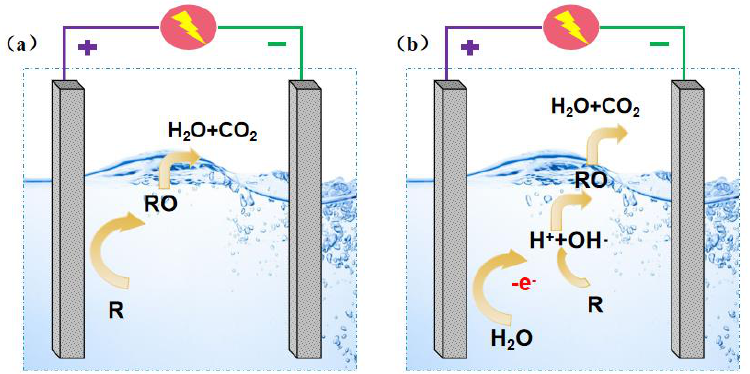
Figure 1. Schematic diagram of direct oxidation ( a ) and indirect oxidation ( b ) of electrocatalytic oxidation technology.